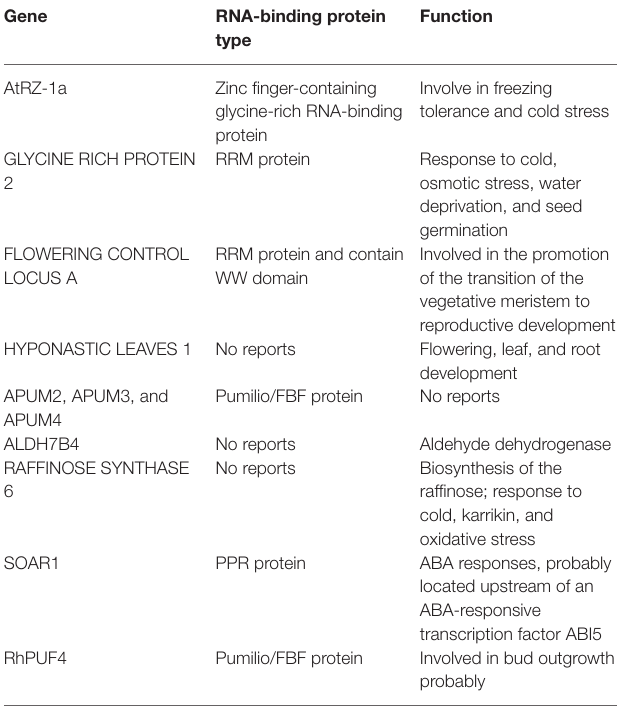
TABLE 1 | The type and function of sugar related